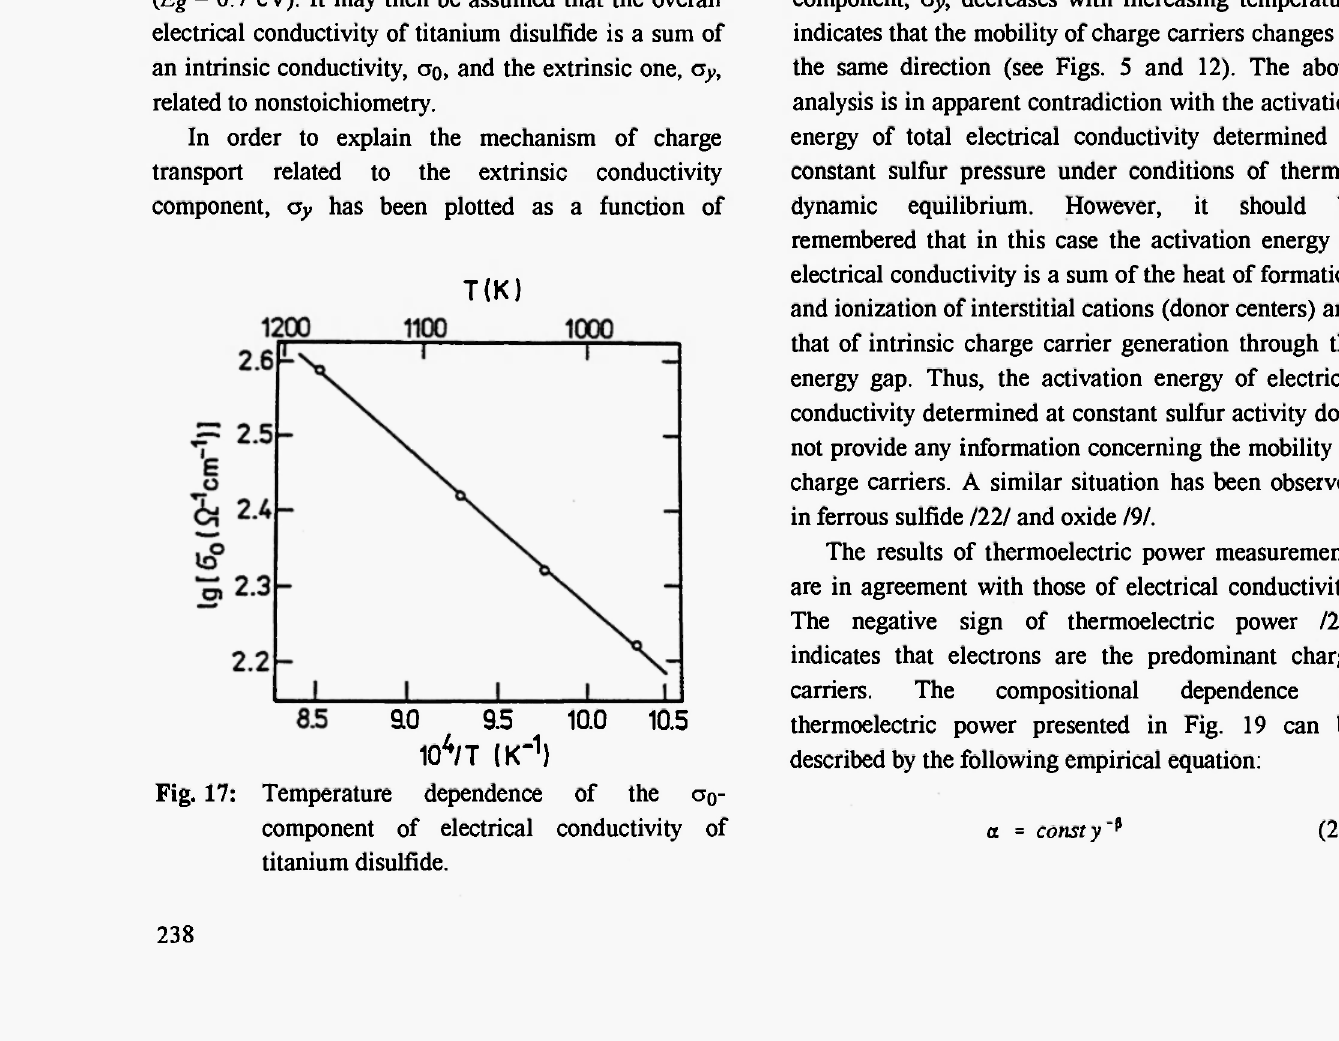
Fig. 18: Temperature dependence of the extrinsic component of electrical conductivity of titanium disulfide having constant deviation from